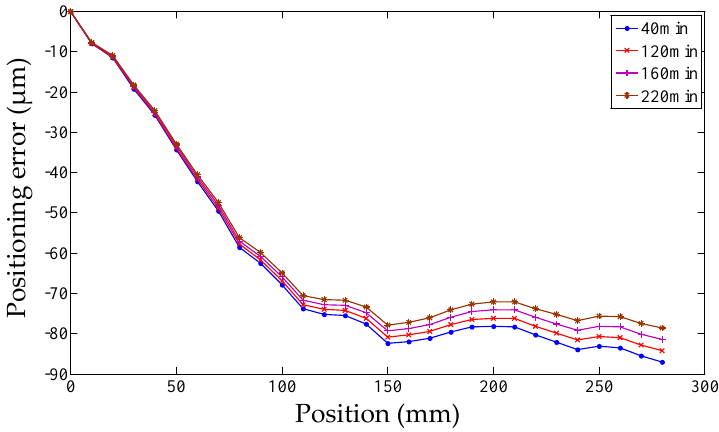
Figure 16. Positioning error of experiment II.